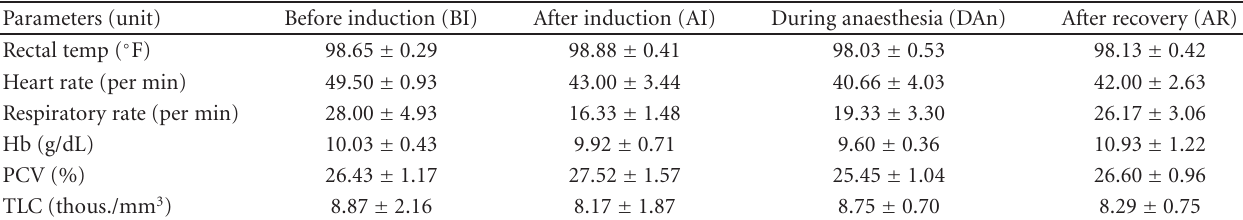
Table 4: Clinical and haematological e ff ects following Xylazine-butorphanol-Guaifenesin-Ketamine anaesthesia in Spiti ponies ( n =